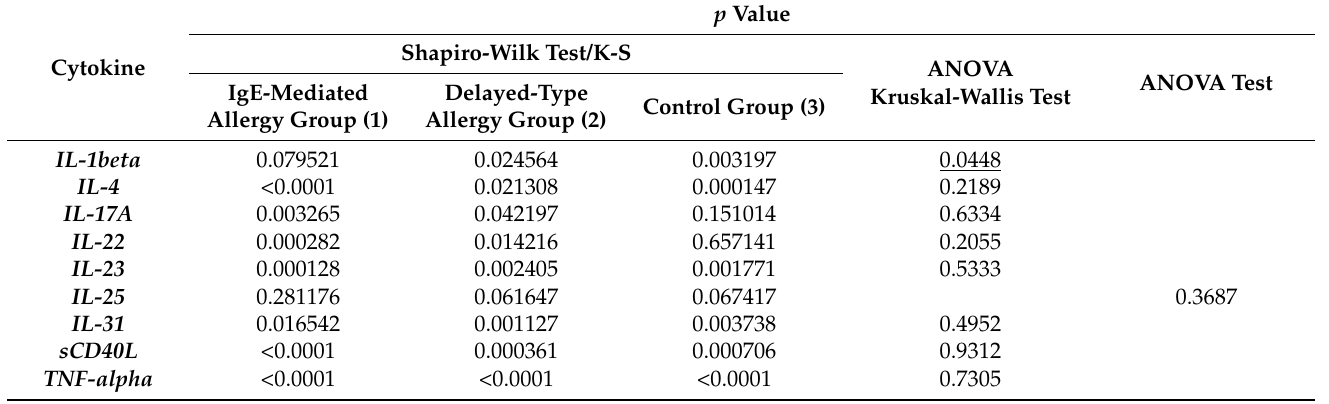
not statistically significant. Table 4. The results of univariate statistical analysis of the serum cytokine concentrations of patients with IgE-mediated allergy (1), delayed-type allergy (2), and participants without food allergy (3). A statistically significant value ( p < 0.05) is